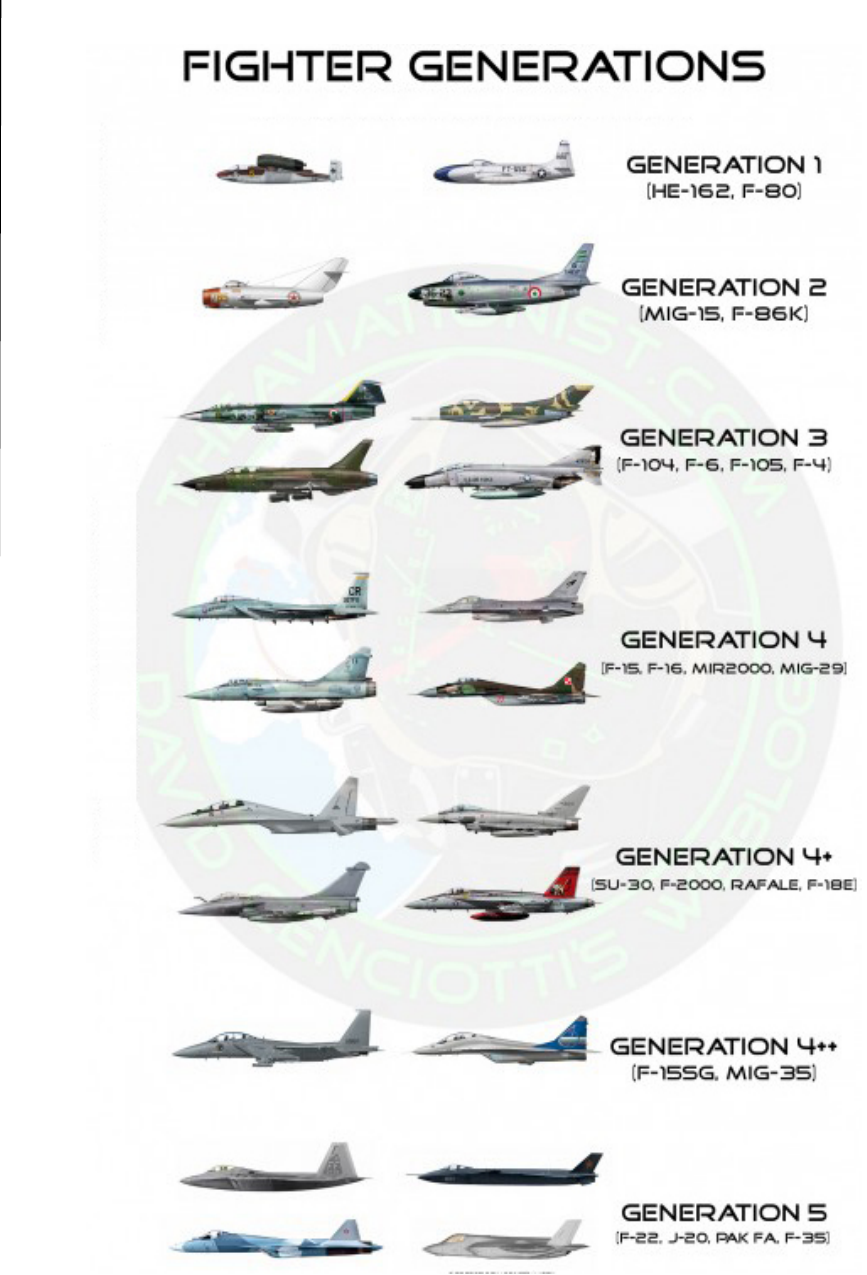
Figure 1 – Generations in fighter aircraft development (Tirpak, 2009, p.40) Рис . 1 – Поколение в развитии боевых самолетов (Tirpak, 2009, p.40) Слика 1 – Генерације у развоју борбених авиона (Tirpak, 2009,